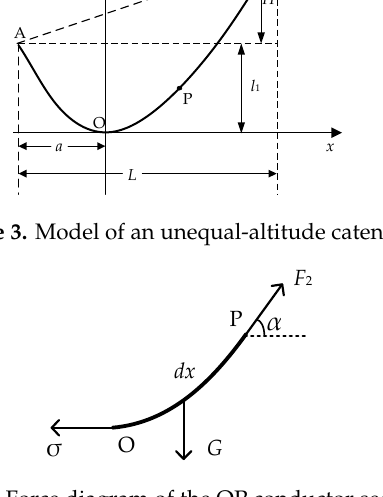
Figure 4. Force diagram of the OP conductor segment.